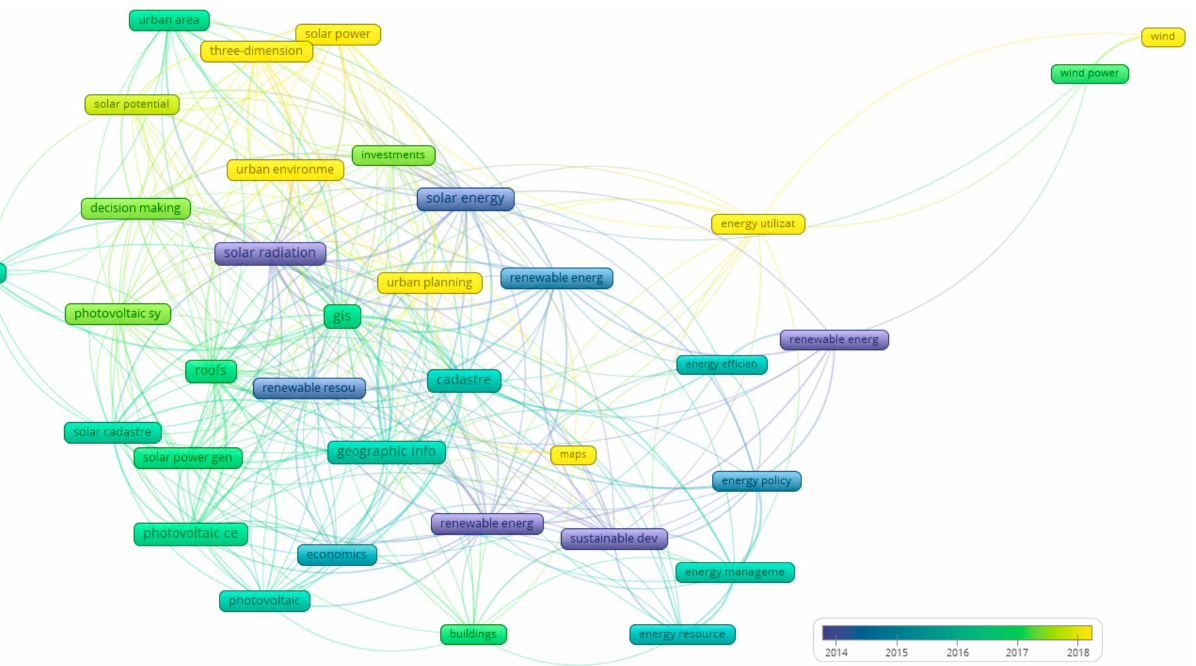
Figure 6. The average publication year of the documents from Scopus in which a keyword occurs. Source: own